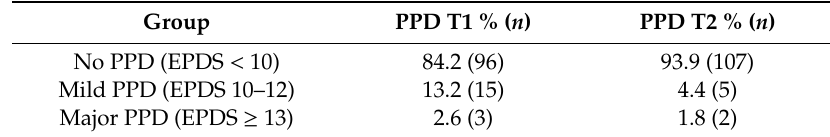
Table 2. Women grouped by their level of symptoms of postpartum depression at T1 (PPD T1) and T2 (PPD